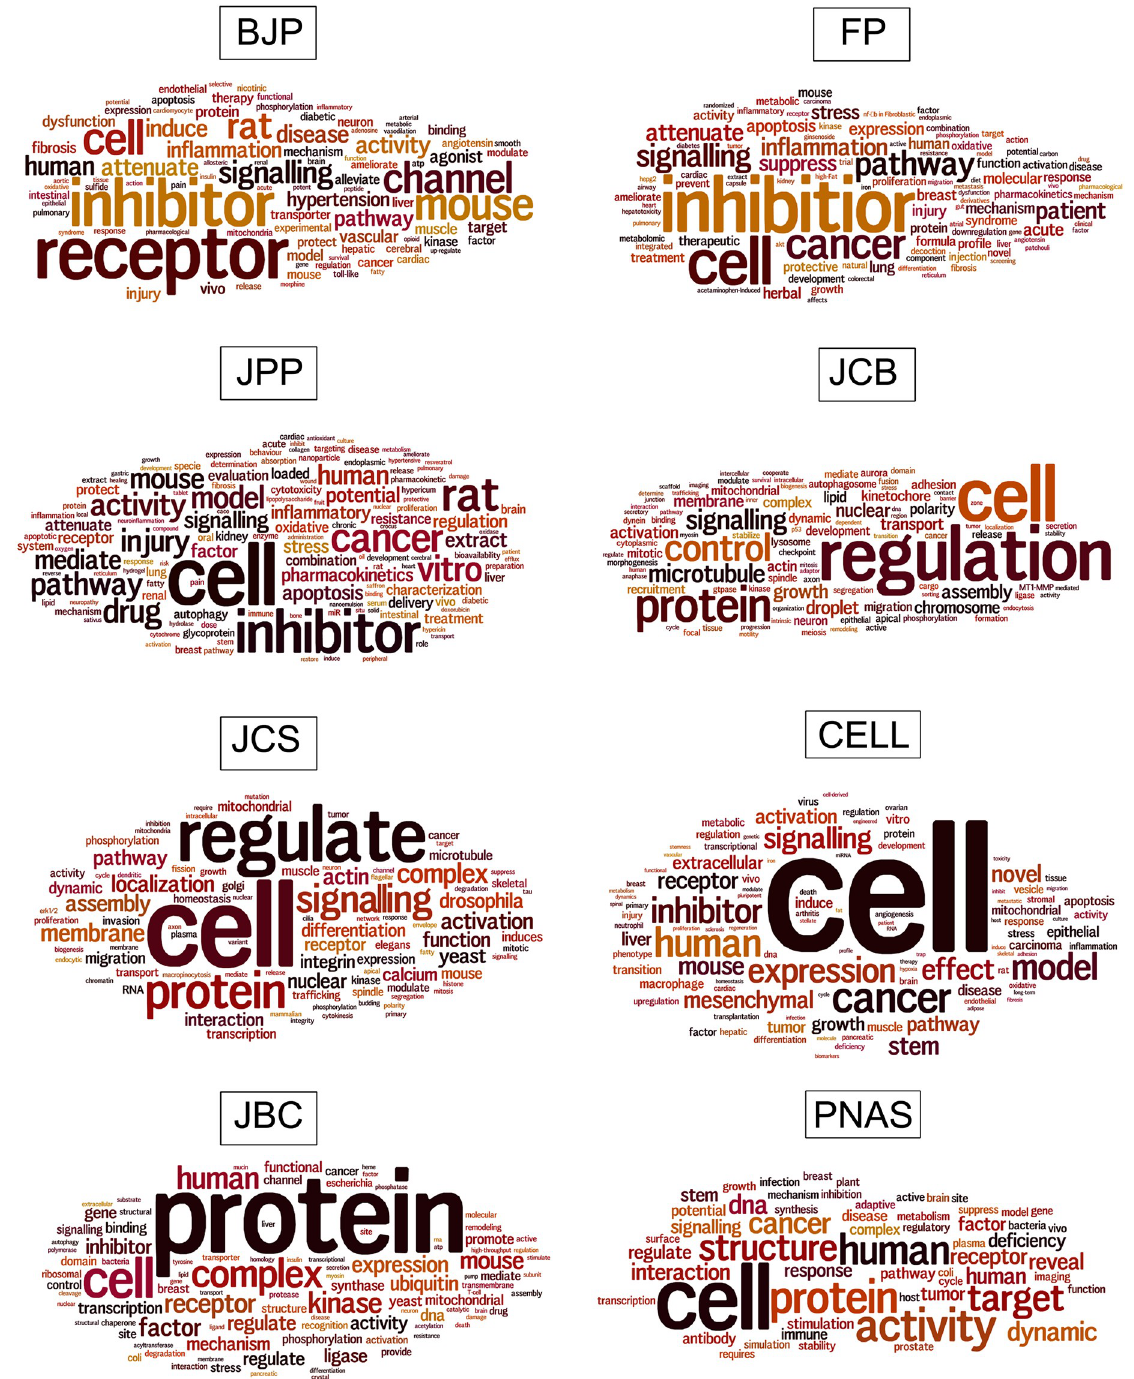
Fig 5. Comparative analysis of the vocabulary of biomedical sciences journals. Word clouds were generated using the titles of articles. The clouds give greater prominence to words that appear more frequently in the source text. Data were collected from articles published